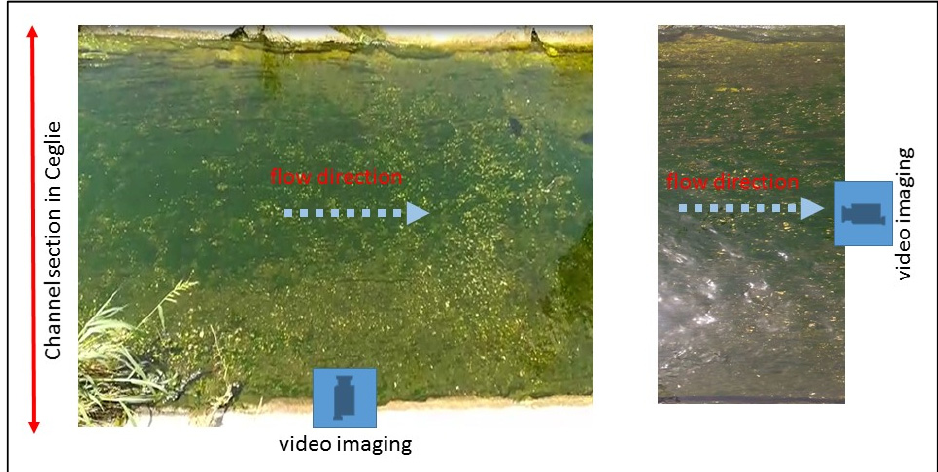
Figure 6. Example of channel photos used for processing (cross-section A).